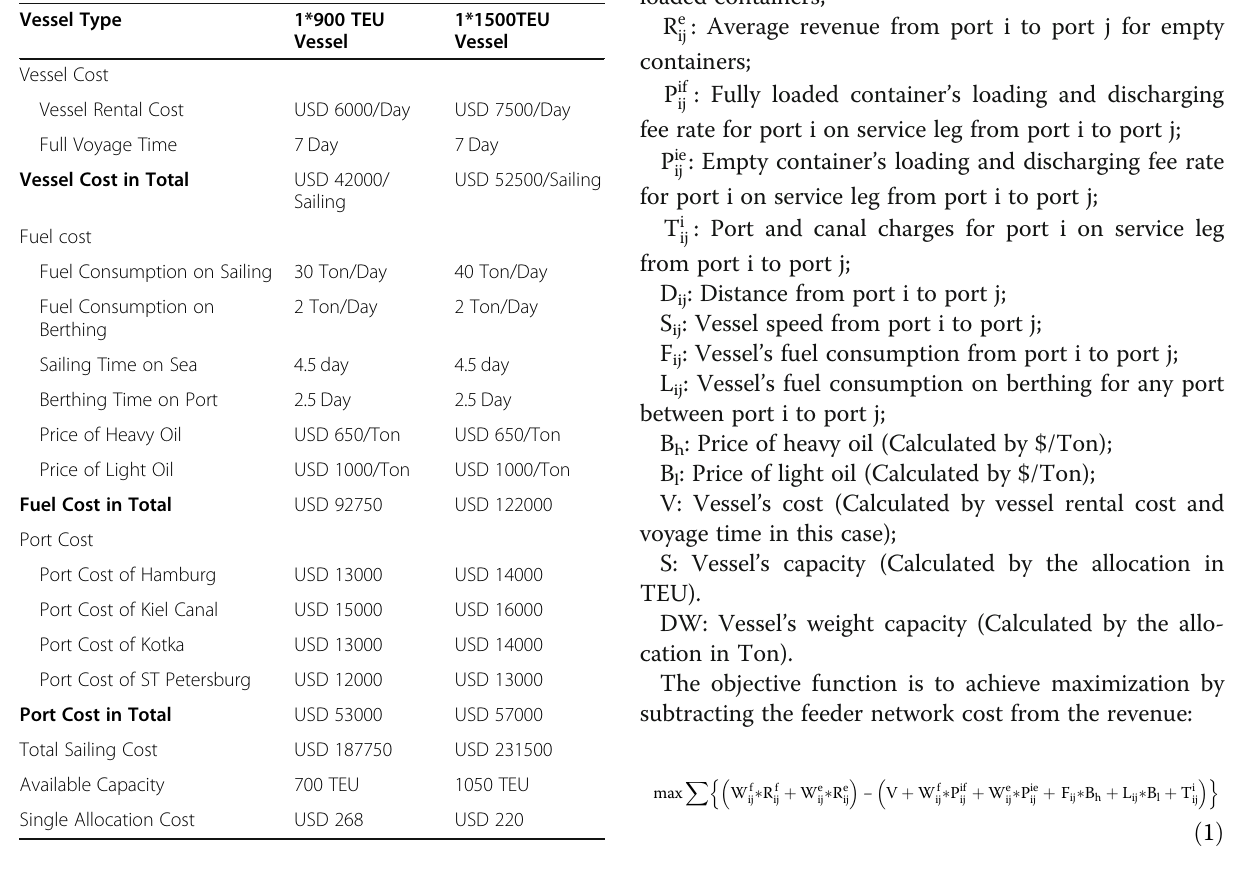
Table 2 Cost Details under Two Available Vessel Types for Possible Own Feeder Service. (Source: authors)